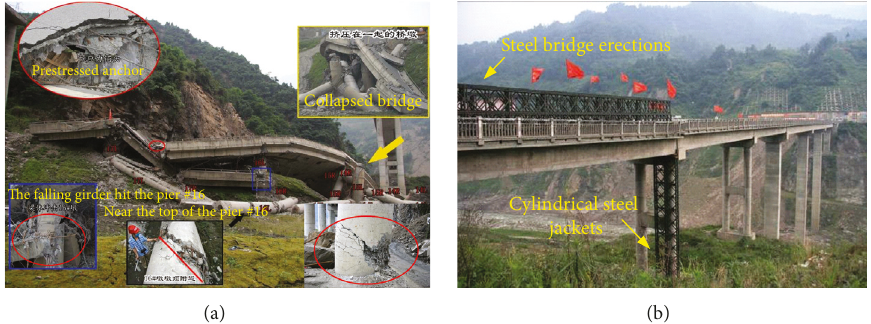
Figure 1: Example of bridge damage during Wenchuan earthquake: (a) collapse of Baihua Bridge due to serious damage to its piers; (b) rapid repair of Shoujiang